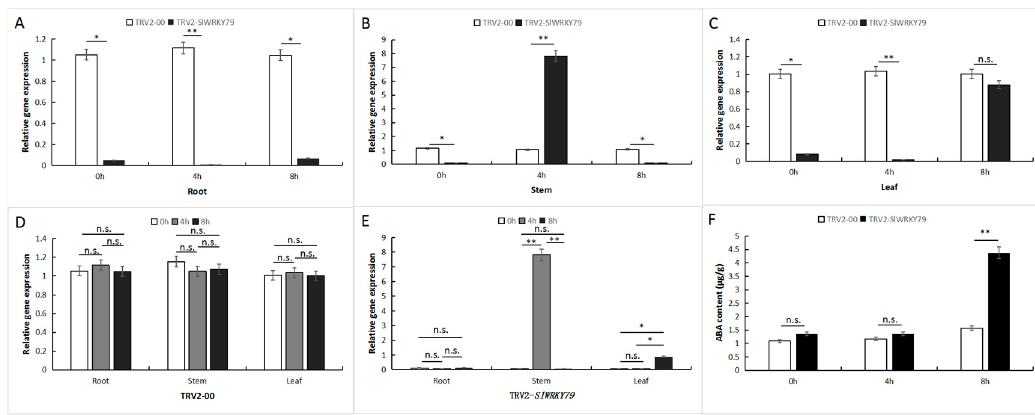
Figure 4. Comparison of SlWRKY79 gene expression levels in roots, stems, and leaves at each time point. ( A ), Comparison of SlWRKY79 gene expression levels in roots; ( B ), comparison of SlWRKY79 gene expression levels in stems; ( C ), comparison of SlWRKY79 gene expression levels in leaves; ( D ), comparison of SlWRKY79 gene expression levels in the roots, stems, and leaves of TRV2-00 plants at different time points; ( E ), comparison of SlWRKY79 gene expression levels in the roots, stems and leaves of TRV2- SlWRKY79 plants at different time points; ( F ), changes in ABA contents in TRV2-00 and TRV2- SlWRKY79 leaves after 0, 4, and 8 h of treatment. The data presented are the means ± standard deviations (SDs) of three independent experiments, and the different letters above the columns indicate significant differences at the p < 0.05 level. *: 0.01 < p < 0.05, **: p < 0.01, and n.s: p > 0.05.